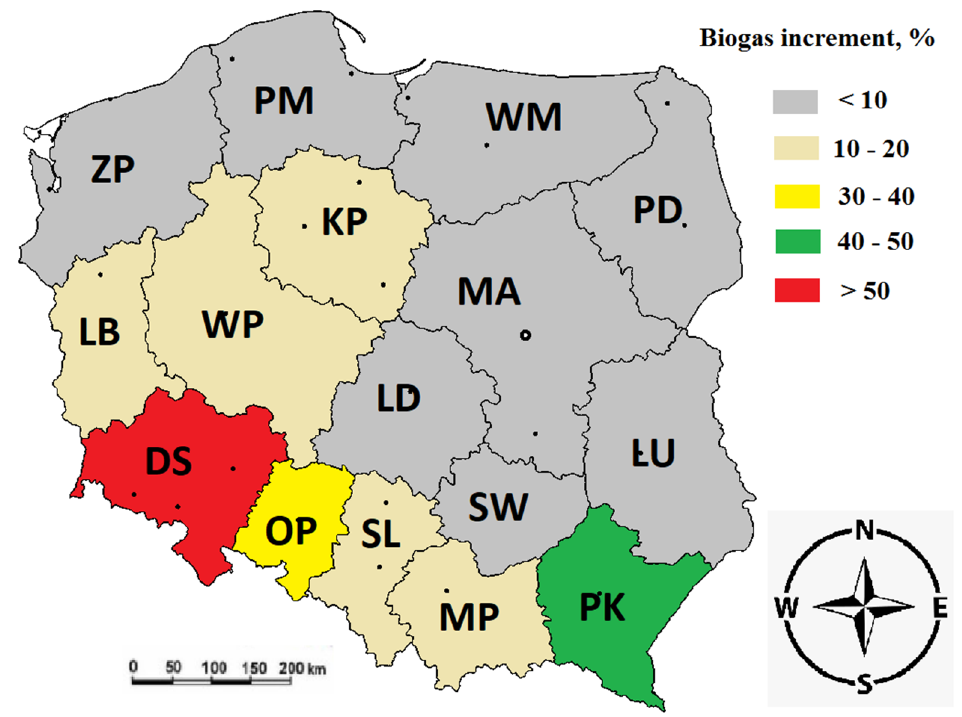
8 of 17 Figure 3. Animal population history.